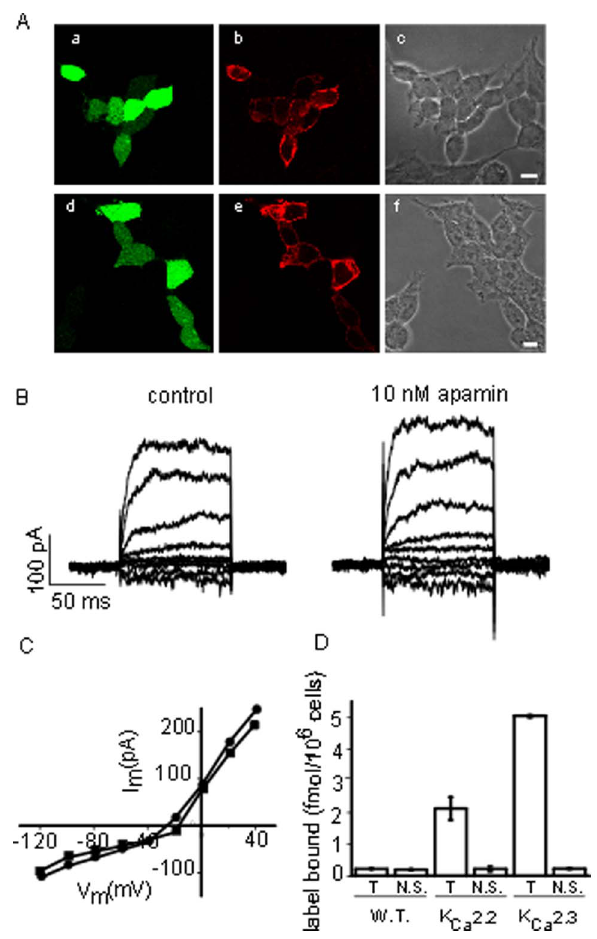
Figure 1. K Ca 2 channels are not expressed in wild type HEK 293 cells. A Immunostaining of HEK 293 cells transiently transfected with GFP and K Ca 2.2 (a,b,c) or K Ca 2.3 (d,e,f). GFP expressing cells are visible in a and d. Comparison with the brightfield images in c and f shows that only a proportion of the cells were transfected. Staining for K Ca 2 channels is shown in b and e where a signal is only visible in cells also expressing GFP. The scale bars indicate 10 m m. B Whole cell currents from a wild type HEK 293 cell recorded using a calcium containing internal solution before ( & ) and after exposure to 10 nM apamin ( The endogenous current is not inhibited. C Current voltage relationship for recordings in B. D Binding of 125 I-apamin to wild type, K Ca 2.2 and